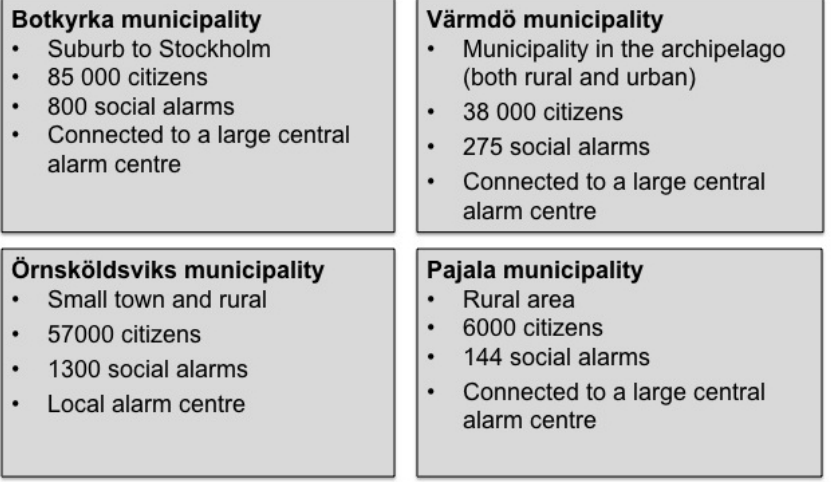
Figure 3. Field studies in four